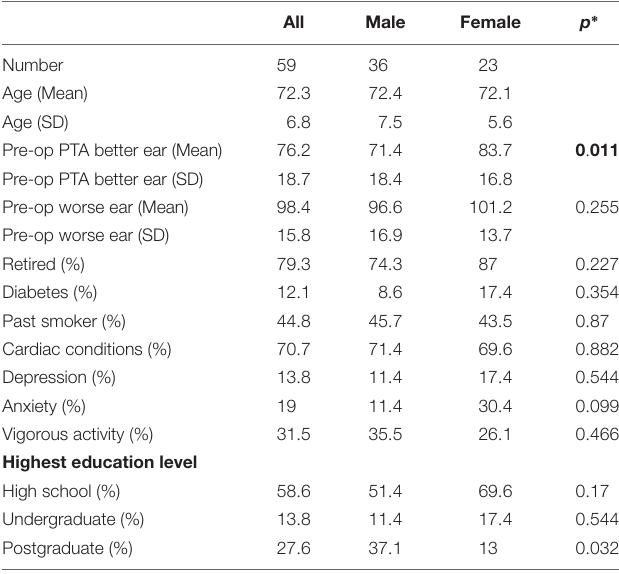
TABLE 1 | Demographic and audiometric characteristics of the study sample ( N =